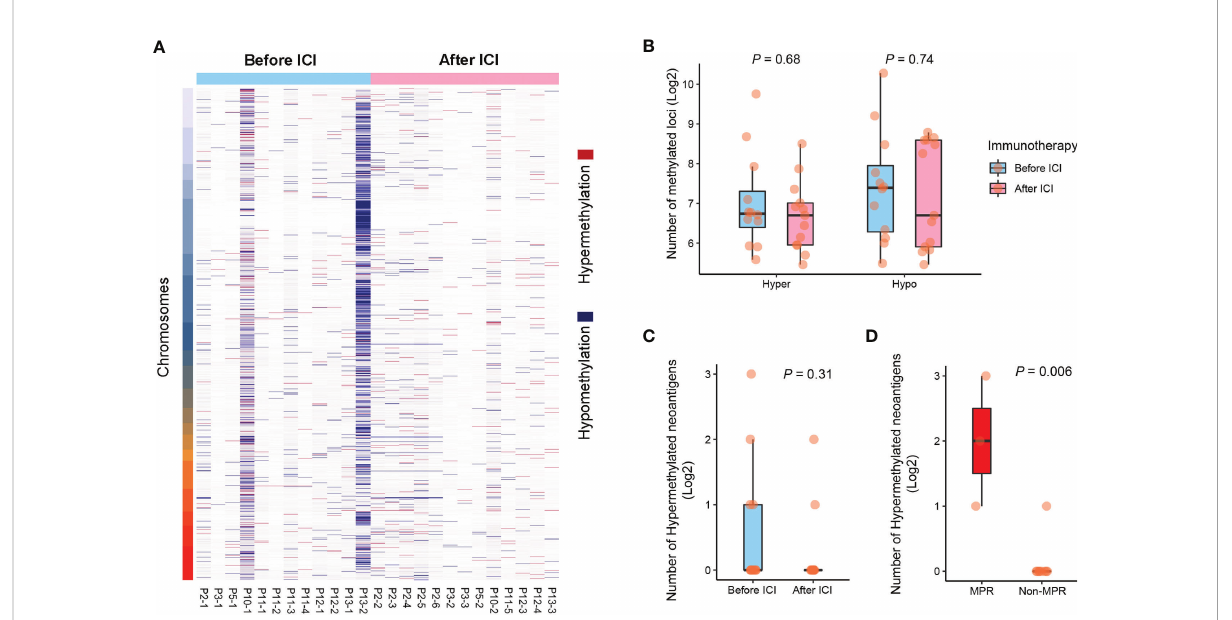
FIGURE 6 Case-speci fi c methylation patterns explained functional neoantigens. (A) Hyper- and hypo-methylated loci among GGOs before and after ICI treatments. (B) Comparison of the number of CpGs before and after ICI treatments. (C) Comparison of the number of hypermethylated neoantigens before and after the use of ICIs. (D) The association between the number of hypermethylated neoantigens and pathologic